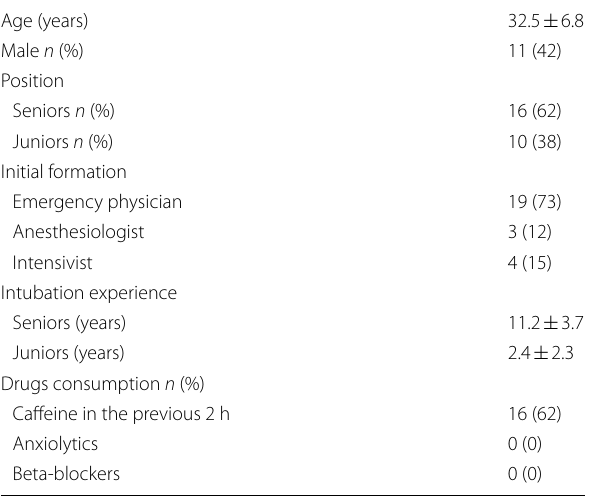
Values are provided as mean